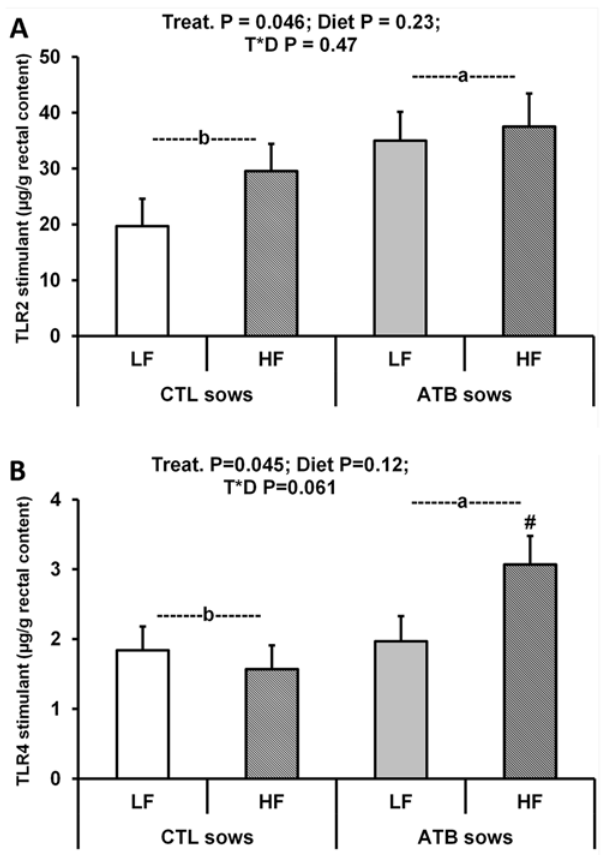
Fig 3. Rectal TLR-stimulant concentrations in fresh rectal contents of offspring born to control or antibiotic-treated sows and fed a LF or a HF diet between 140 and 169 days of age (LSmeans and SEM, n = 10 per treatment and diet). A. TLR2-stimulant concentration was significantly higher (P < 0.05) in fresh rectal contents of offspring born to ATB sows compared to controls when fed the LF diet. B. Rectal TLR4- stimulant concentration was significantly higher (P < 0.05) in fresh rectal contents of offspring born to ATB sows and fed the LF diet, compared to the other groups (treatment by diet interaction, P = 0.061; LSmean with # tended to be different from the others, P <